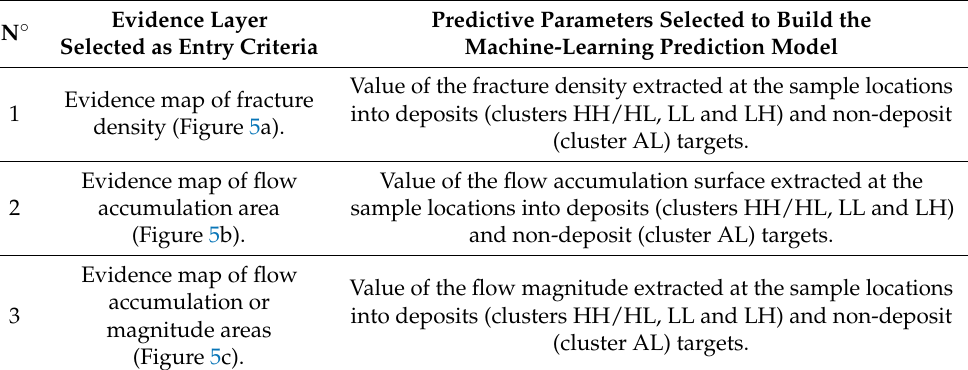
Table 2. Summary of all the evidence layers and features used to build the machine-learning prediction